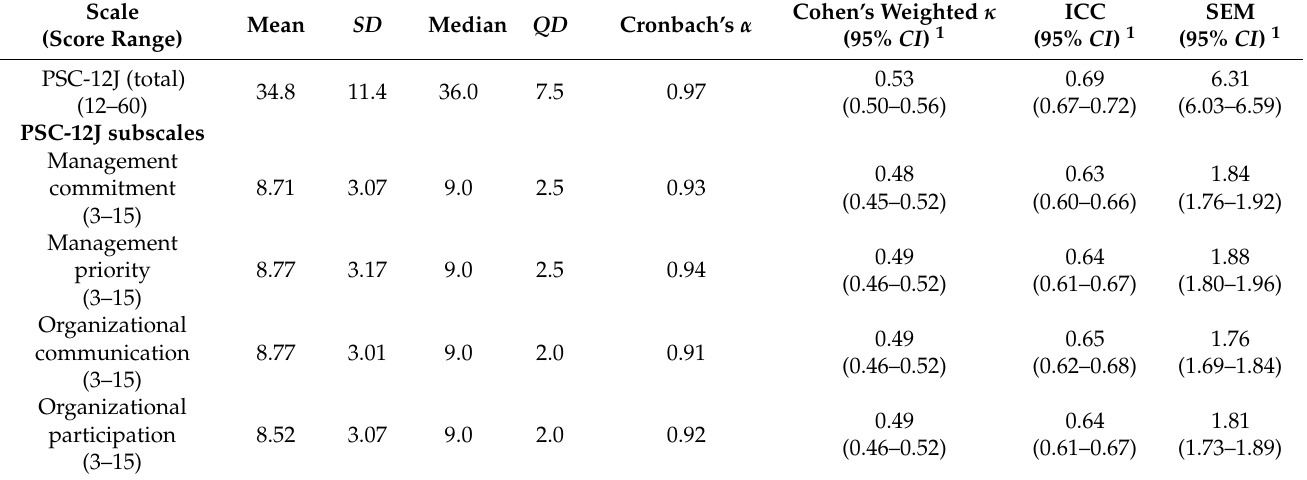
Table 2. Means, standard deviations ( SD s), medians, quartile deviations ( QD s), Cronbach’s α coefficients, Cohen’s weighted κ coefficients, intraclass correlation coefficients (ICCs), and standard error of measurement (SEM) for the PSC-12J and its subscales ( N = 2200 for mean, SD , median, QD , and Cronbach’s α coefficient; N = 1400 for Cohen’s weighted κ coefficient, ICC, and